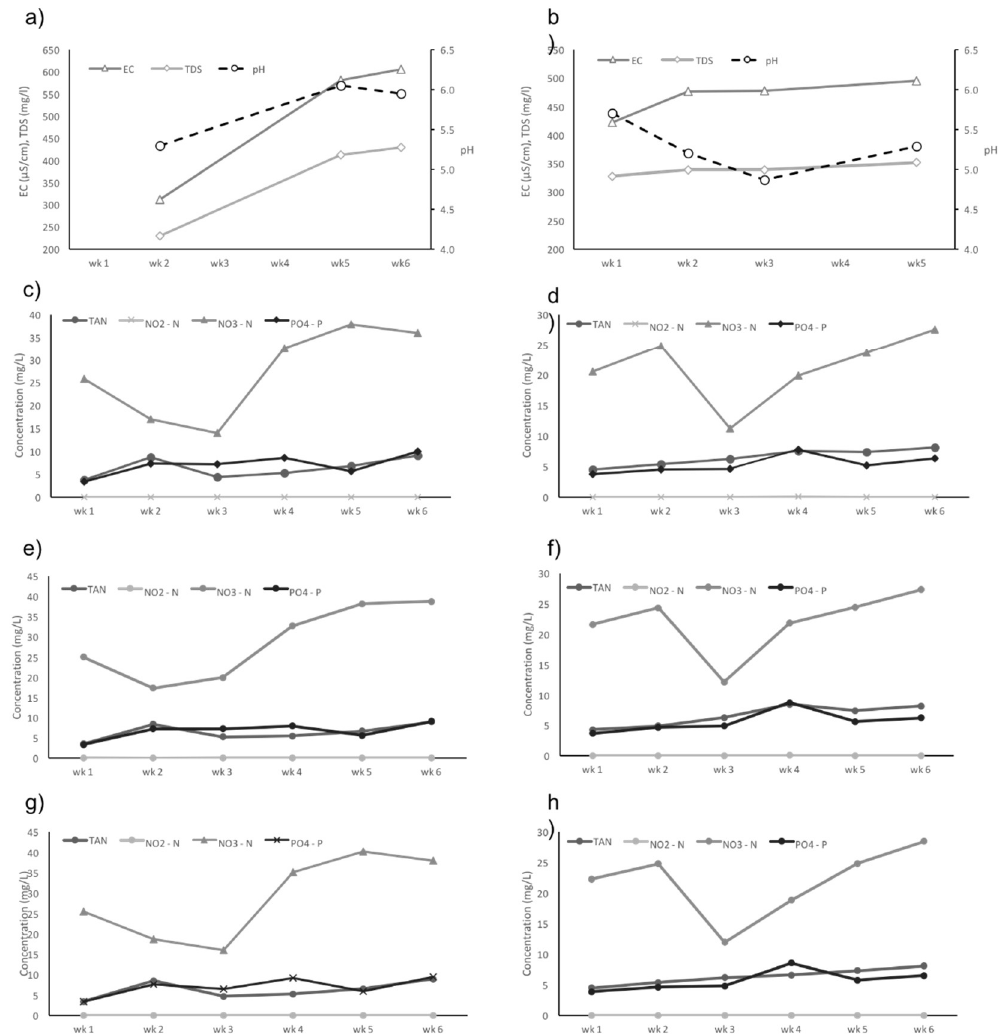
Figure 5. Nutrient water quality and dynamics in System 4 Trials 1 and 2 were monitored over a 6-week period and the mean concentrations for all parameters measured in the growbeds pairs are presented. The pH, EC, and TDS are shown for ( a ) Trial 1 and ( b ) Trial 2. The N-species and phosphate (PO 4 -P) dynamics are shown for the growbeds at three di ff erent flowrates: ( c ) Trial 1-Growbed Pair A, 500 L / h, ( d ) Trial 2-Growbed Pair A, 500 L / h, ( e ) Trial 1-Growbed Pair B, 160 L / h and ( f ) Trial 2-Growbed Pair B, 160 L / h, ( g ) Trial 1-Growbed Pair C, 40 L / h and ( h ) Trial 2-Growbed Pair C, 40 L / h.